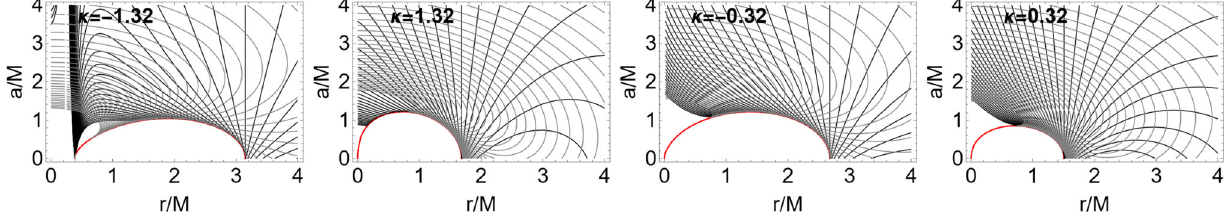
Fig. 15 Metricbundlesfor BHs inperfect-fluiddarkmatterofEq.(49) for θ = π/ 2 and M = 1. The red curves are the horizons and envelope surfaces of the metric bundles. Different values of k ≷ 0, describing